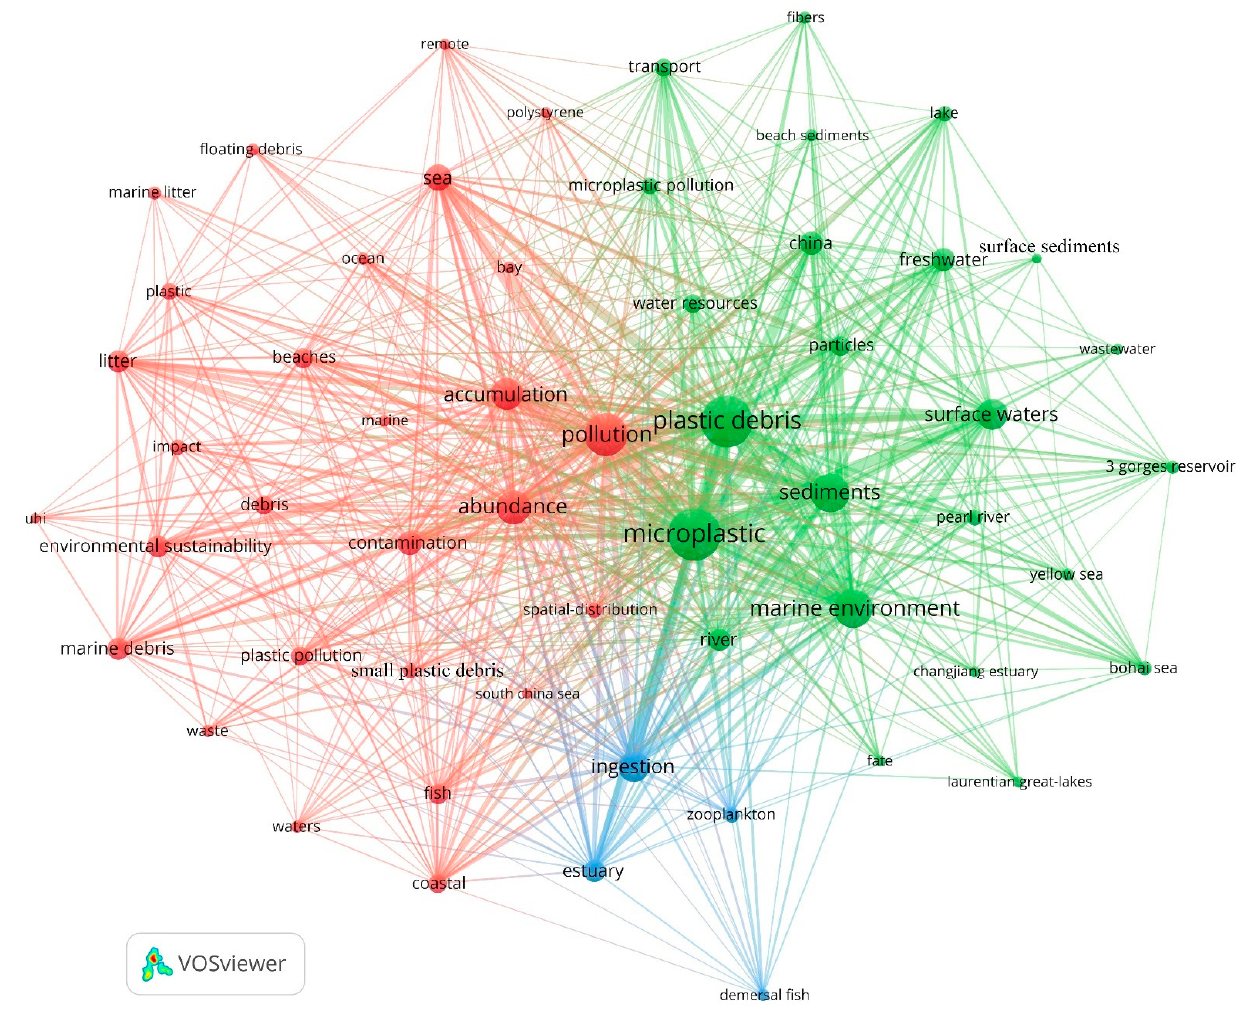
Figure 2. Co-occurrence analysis on terms associated with plastic pollution and riverine contexts in Asia (Derived from VOSviewer).